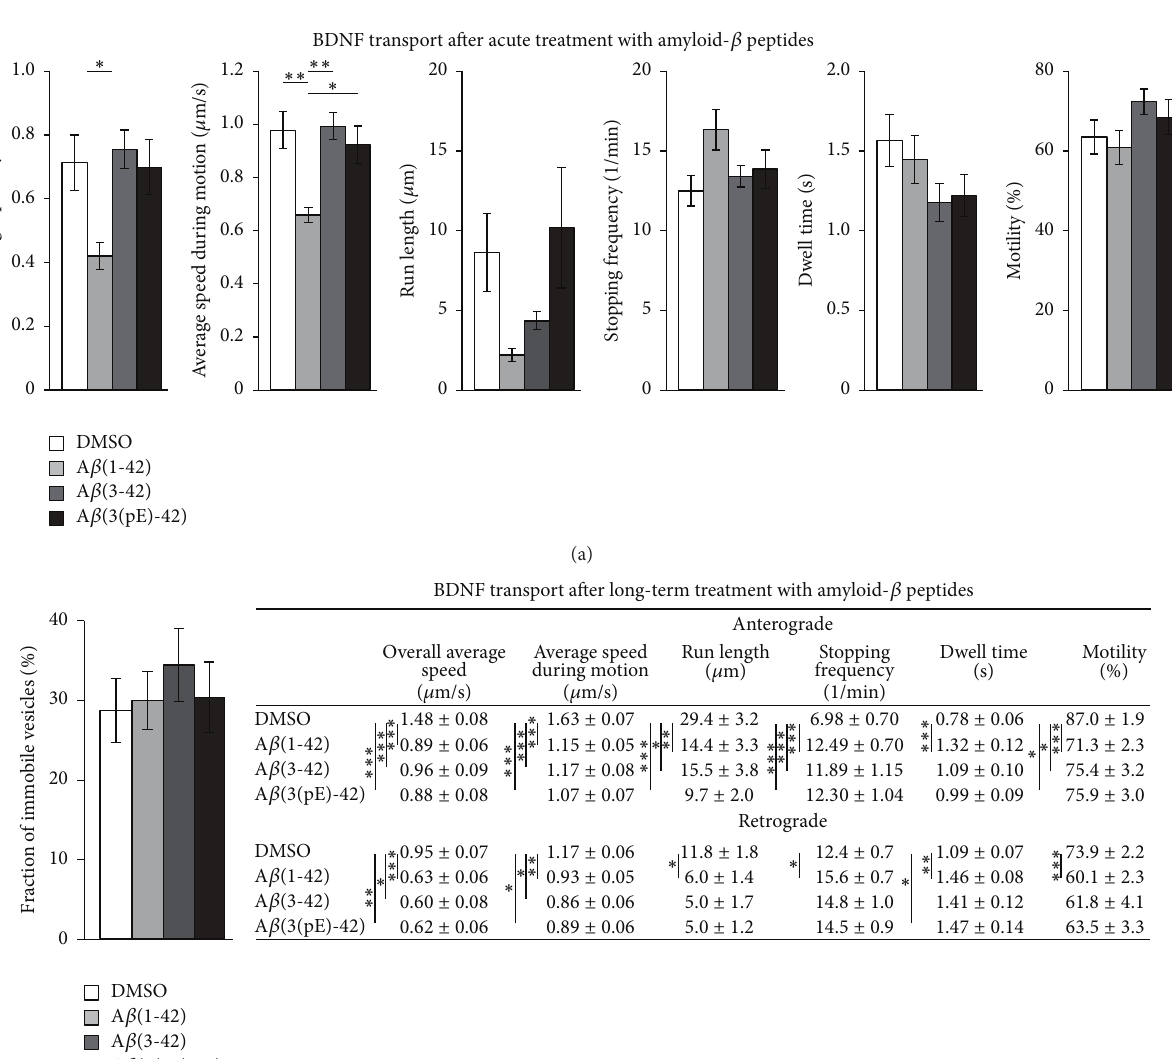
Figure 4: Application of amyloid-beta(1-42) altered BDNF transport with faster onset than observed for other A 𝛽 peptides. Dissociated hippocampal neurons derived from 5xFAD wild-type littermates were transfected at 10 DIV with fluorescently labeled BDNF. The dynamic behavior of BDNF-containing vesicles was analyzed by live cell imaging after (a) acute and long-term (b) treatment with different amyloid- beta peptides. (a) Acute treatment with amyloid-beta(1-42) influenced average speed of retrogradely directed BDNF-containing vesicles. Bar diagrams show the mean values of the indicated motional properties after acute treatment with different amyloid-beta peptides. The average speed during motion was significantly reduced in neurons treated with amyloid-beta(1-42) compared to neurons treated with solvent (0,1% DMSO), amyloid-beta(3-42), or amyloid-beta(3(pE)-42), respectively ( ∗ 𝑝 < 0.05 , ∗∗ 𝑝 < 0.01 , one-way ANOVA followed by post hoc Tukey Test).(b)Long-termtreatmentwithamyloid-beta(24 h)influenceddifferentmotionalpropertiesofBDNFtransport.(left)Bardiagramshows the percentage of immobile BDNF-containing vesicles in hippocampal neurons after treatment with different amyloid-beta peptides. (right) Table shows the mean values for the different motional properties of anterogradely and retrogradely directed BDNF-containing vesicles in hippocampal neurons. Note that all motional properties were significantly changed after 24 h treatment with amyloid-beta(1-42) compared to control conditions. Long-term incubation with amyloid-beta(3-42) or amyloid-beta(3(pE)-42) also significantly influenced some motional properties of BDNF-containing vesicles ( ∗ 𝑝 < 0.05 , ∗∗ 𝑝 < 0.01 , ∗∗∗ 𝑝 < 0.001 ; one-way ANOVA followed by post hoc Tukey’s test). Error bars represent